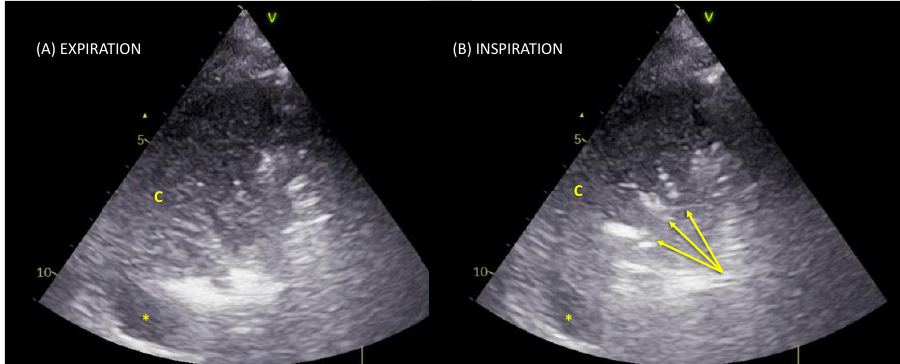
Figure 1. Lung ultrasound scan of a typical linear–arborescent air bronchogram. Posterior region in the transversal scan with a phased-array probe. Panel ( A ) in expiration, a tissue-like pattern corresponding to a consolidation (c) is visualized; a small pleural effusion is also visible as an anechoic space (*). Panel ( B ) during inspiration, a linear–arborescent air bronchogram appears (yellow arrows): a sign highly specific for ventilator-associated